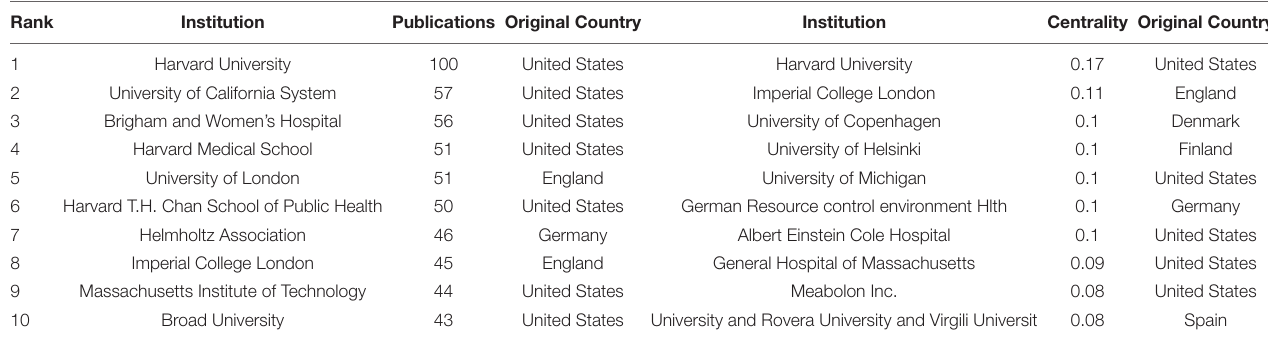
TABLE 2 | Top 10 institutions distributed by publications and centrality with regards to coronary artery disease and metabolome research. Rank